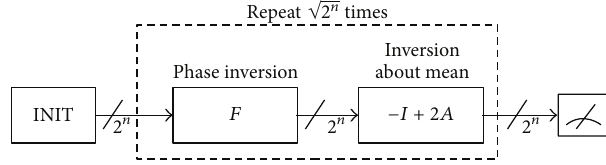
Figure 11: Mathematical modelling of Grover’s search